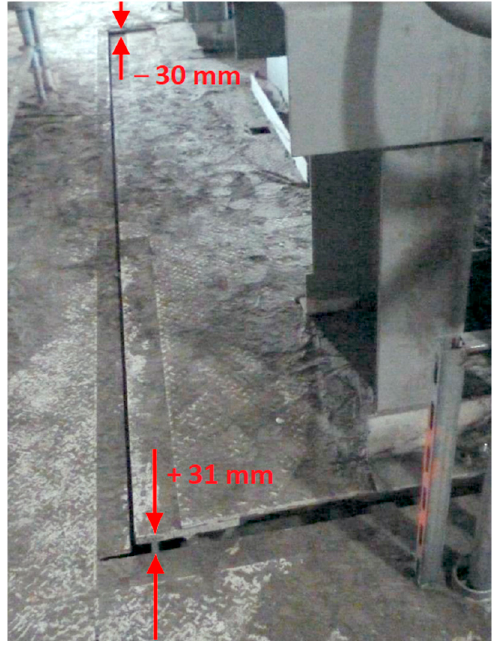
Figure 6. Displacements of the structure.